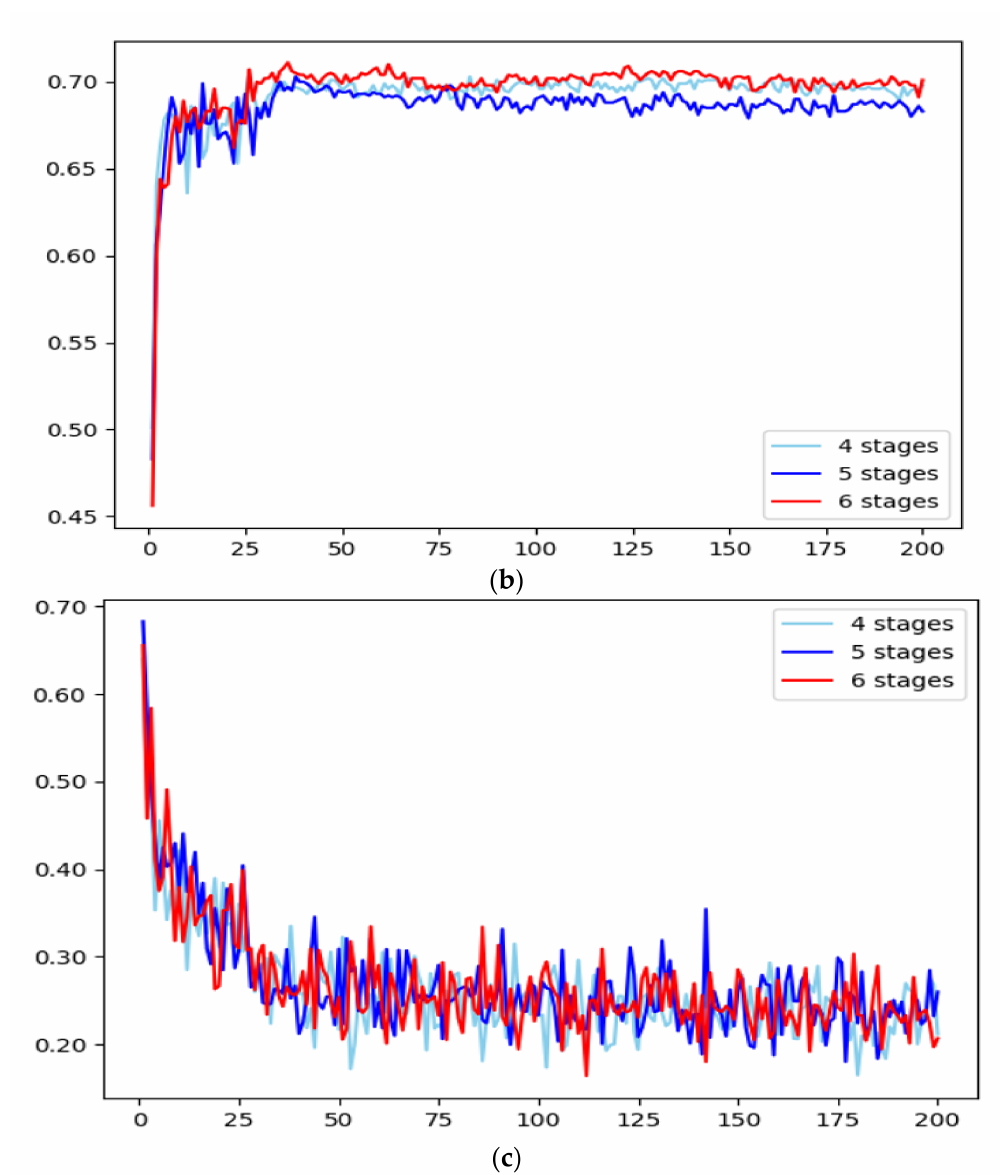
Figure 5. Result analysis of Swin Transformer architecture with different stages: ( a ) the mAP results in case of IoU = 0.5; ( b ) the mAP results in case of IoU = 0.50:0.05:0.95; ( c ) training